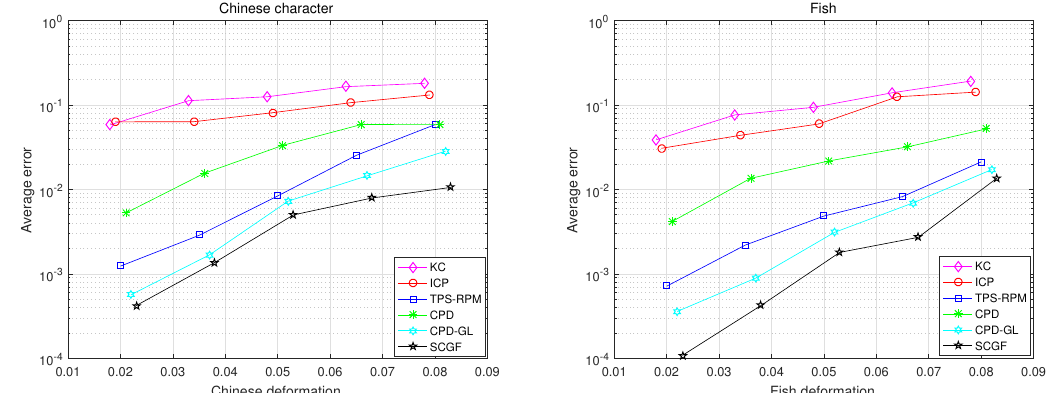
Figure 8. MSED, in log-scale, achieved from the application of the under-comparison pair-wise registration algorithms on the Chinese characters set and fish shapes for different levels of degradation.